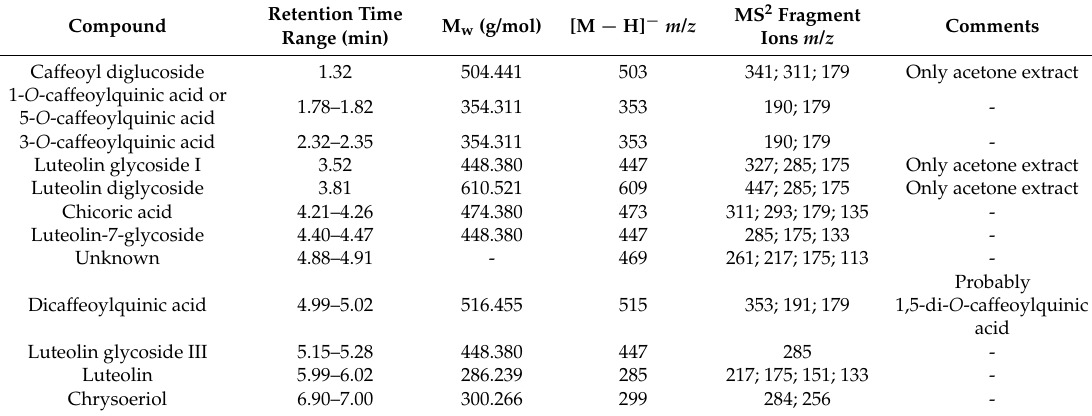
Table 4. UHPLC-MS identification of main polyphenol compounds in Taraxacum officinale flowers extracts. Compound